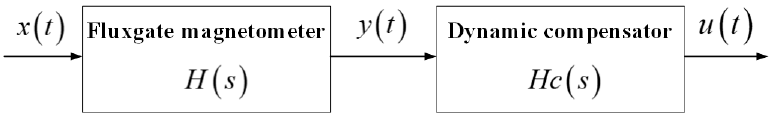
Figure 5. Dynamic characteristic compensation principle of the fluxgate magnetometer.